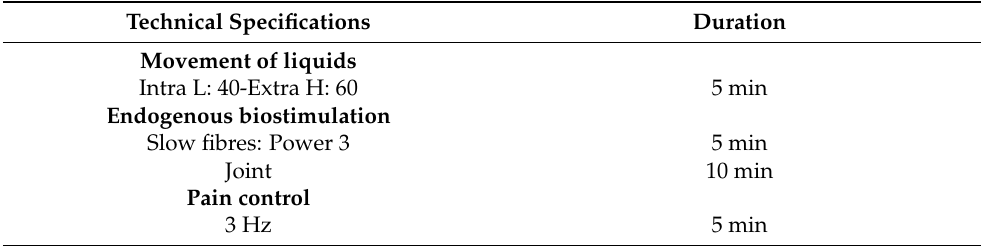
Table 1. Protocol applied during each treatment